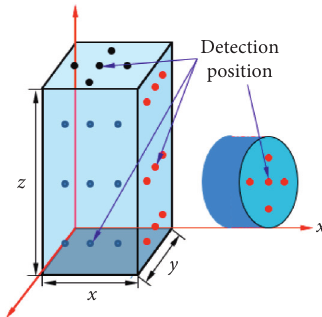
Figure 3: Ultrasonic inspection position distribution of the coal